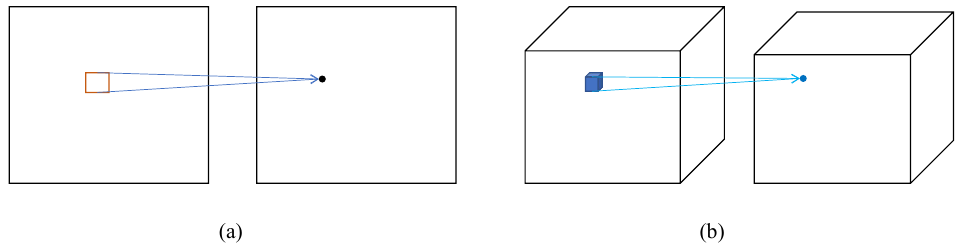
Figure 3. Schematic diagram of convolution structure, ( a ) 2D convolution operation, ( b ) 3D convolu- tion